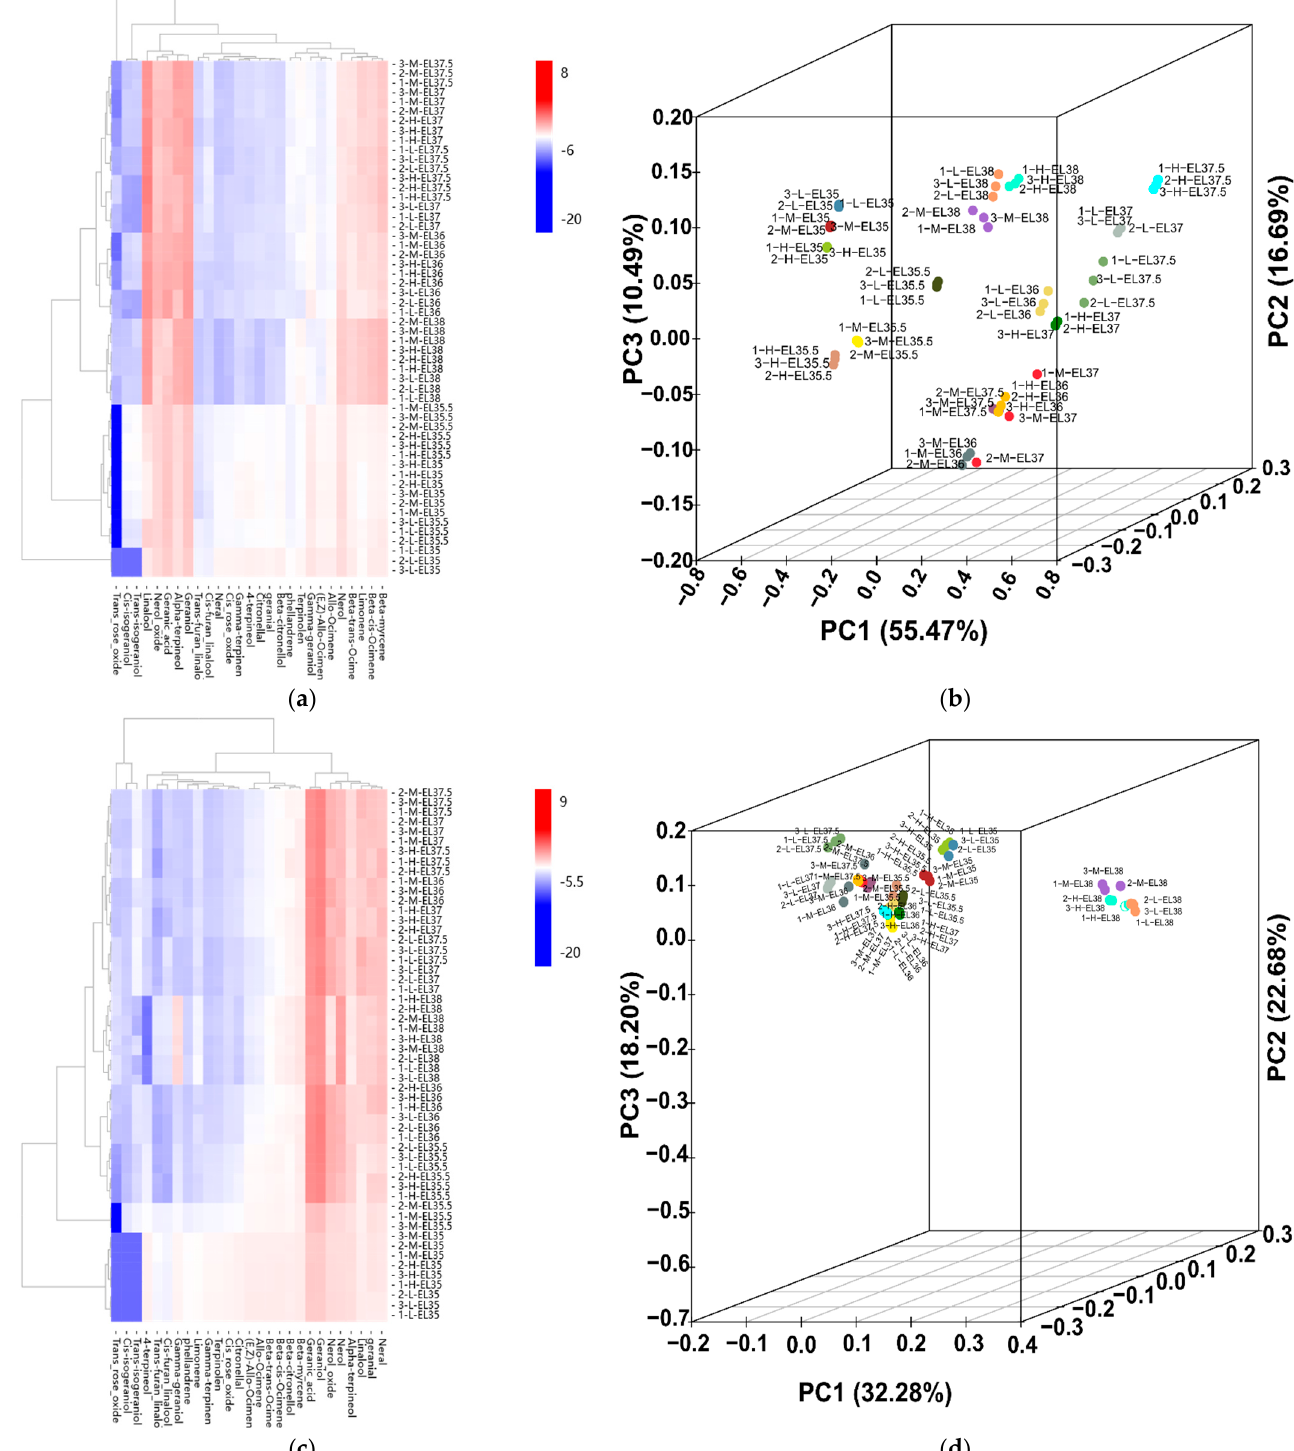
Figure 1. Influence of cluster thinning on the content of free and bound monoterpenes. ( a ) Heat map of free monoterpene compounds after sucrose treatment. ( b ) Principal component analysis (PCA) of free monoterpenes. ( c ) Heat map of bound monoterpene compounds after sucrose treatment. ( d ) Principal component analysis (PCA) of bound monoterpenes.